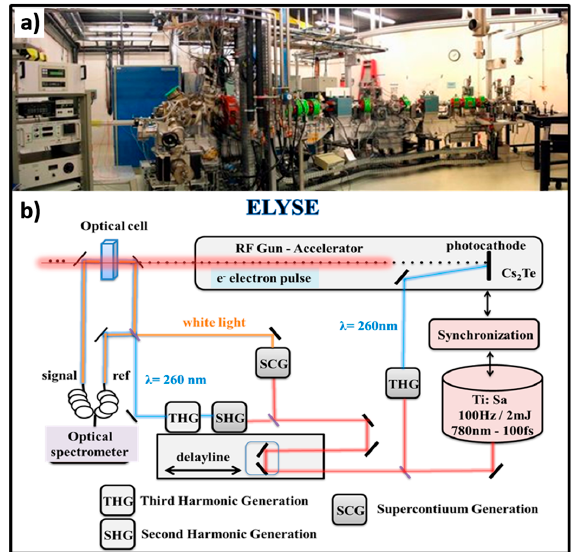
Figure 1. ( a ) Pulse radiolysis facility (unique in Europe) based on the ELYSE picosecond pulsed electron accelerator from the Physical Chemistry laboratory in Orsay, France; ( b ) Schematic description of the synchronizing the electron beam for ionization with a laser beam to probe the species created by the electron pulse. The spectroscopic technique used for this study is the transient absorption based on the pump-probe principle, which makes it possible to overcome the limited temporal resolution of electronic detectors. The setup makes it possible to repeat the measurement for different delays between the pump and the probe and at different wavelengths, and it is thus possible to reconstitute step by step the evolution of the transient